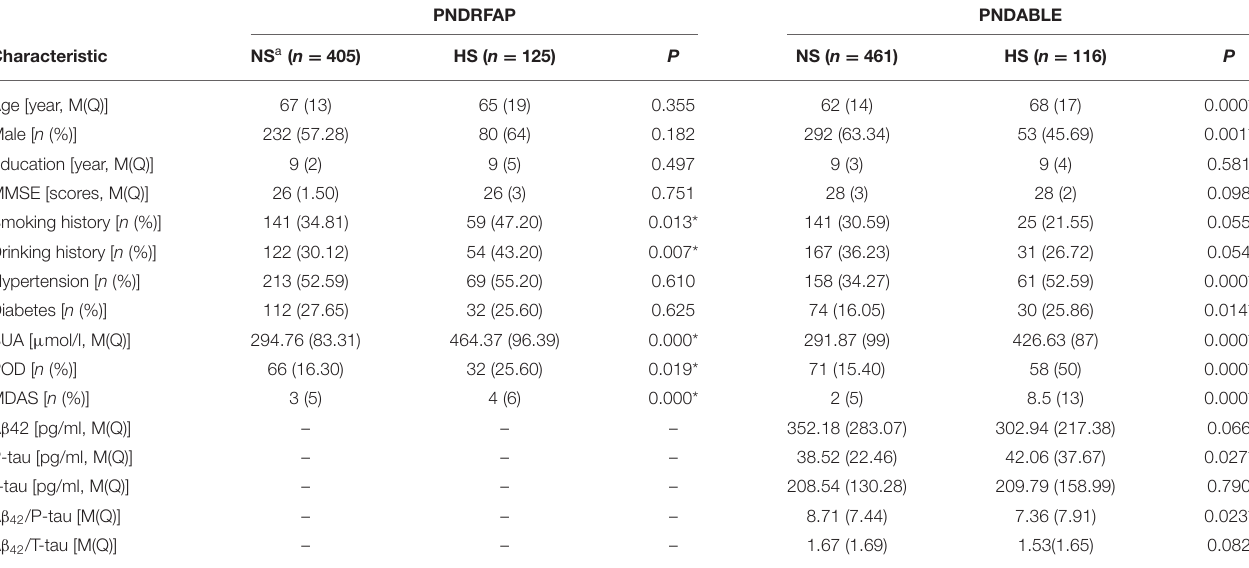
TABLE 1 | Characteristics of participants in PNDRFAP and